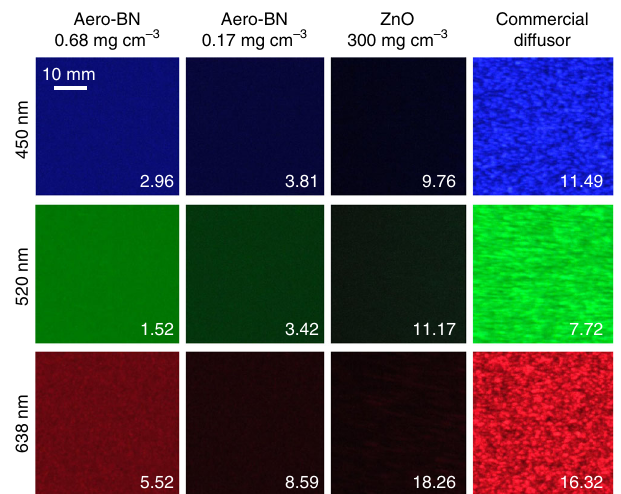
Fig. 5 Speckle contrast reduction. Objective speckle pattern at 450, 520, and 638 nm for two Aero-BN samples with high ( ρ Aero-BN ~0.68 mg cm − 3 ) and low ( ρ Aero-BN ~0.17 mg cm − 3 ) density, a porous ZnO microrod network ( ρ T ~300 mg cm − 3 ) and a commercial plate diffuser. Values for speckle contrast are in